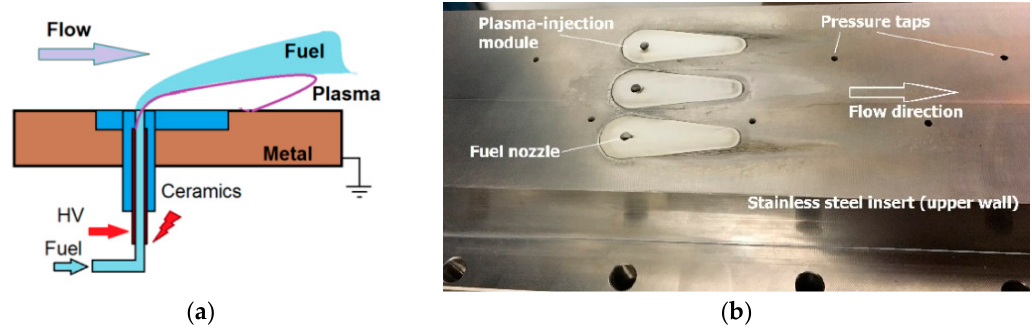
Figure 13. ( a ) Schematics of fuel injector and electrode arrangement; ( b ) photo of PIMs in the test